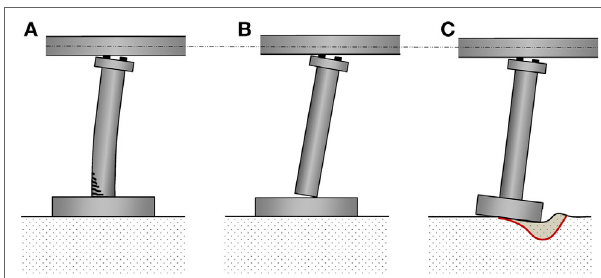
FigUre 2 | Studied configurations: (a) conventional system; (B) rocking piers; and (c) rocking footings.